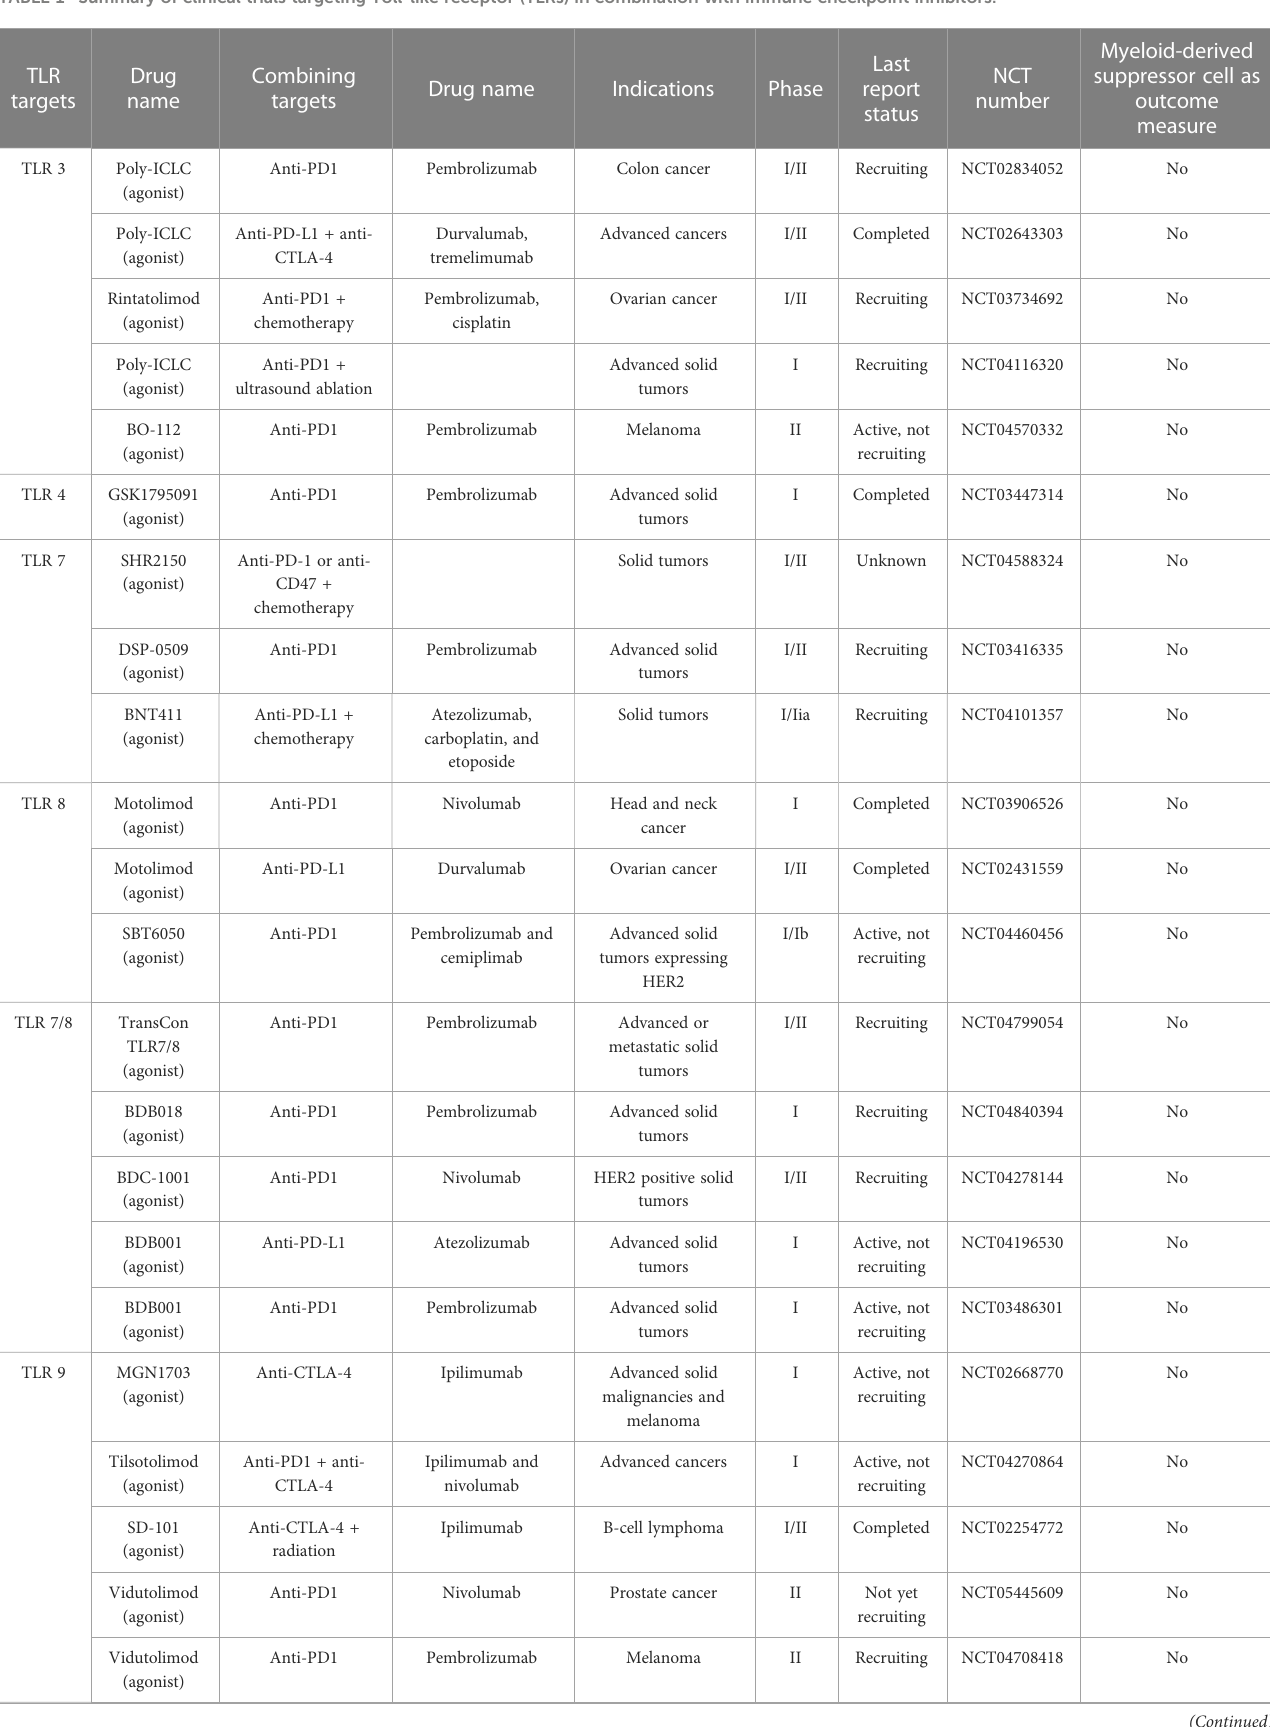
TABLE 1 Summary of clinical trials targeting Toll-like receptor (TLRs) in combination with immune checkpoint